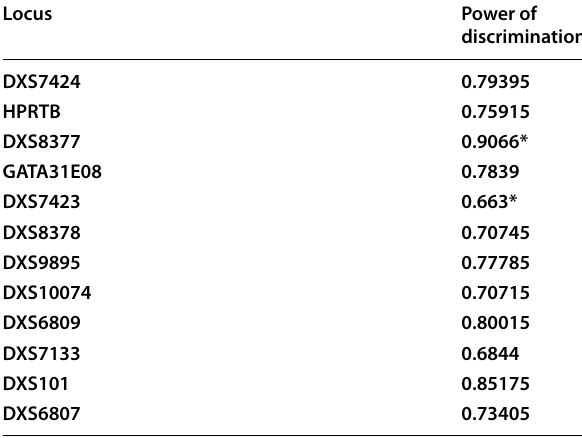
*The significance value of power of discrimination (> 0.05)